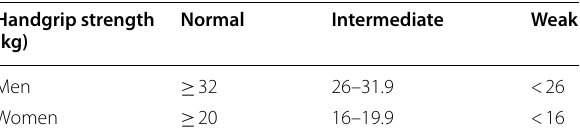
Table 6 Normative cutoff values for handgrip strength according to the FNIH Sarcopenia Project Handgrip strength